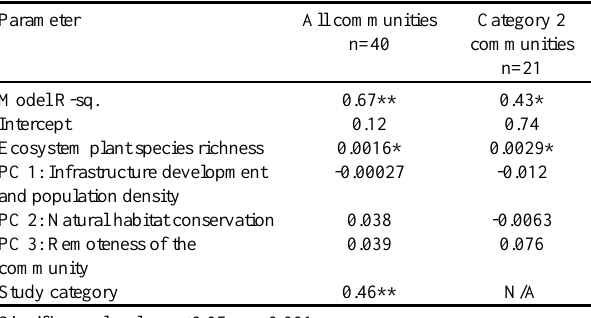
Table 3 . Effect of ecosystem plant species richness, socioeconomic, environmental, geographical, and methodological factors on plant use richness among 40 Ecuadorian